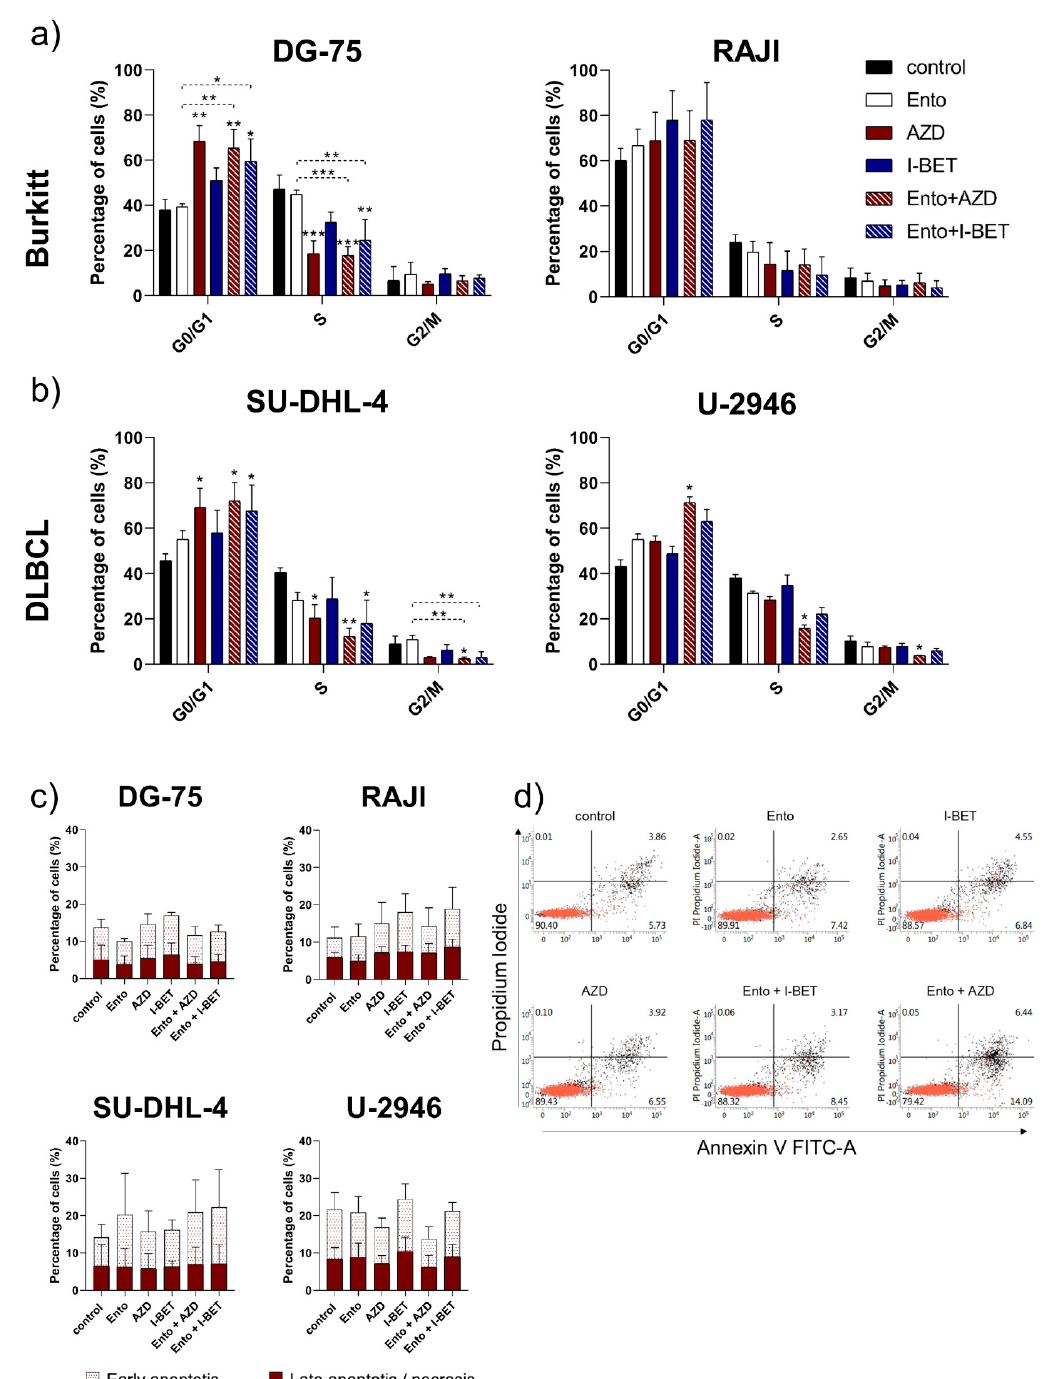
Figure 4. Cell cycle analysis and apoptosis measurement after combined BET and SYK inhibition. Cell cycle analysis was performed 72 h after agent exposure by PI staining and DNA content was measured by flow cytometry. Percentage of cells per cell cycle phase was calculated using FlowJo Software. ( a ) Mean cell cycle distribution of BL cell lines. ( b ) DLBCL cell lines. ( c ) Apoptosis was measured by Annexin V/PI double staining 72 h after incubation. ( d ) Representative dot plots of apoptosis induction in the SU-DHL-4 cell line. Data are presented as the mean ± SD. Statistical significance was calculated by one-way ANOVA followed by Tukey’s multiple comparison test as a post hoc analysis. Kruskal–Wallis test was applied to non-parametric data. Statistical significance is displayed as * p < 0.033, ** p < 0.002, *** p < 0.001 versus control and further versus the respective single agents (dashed lines) (n ≥